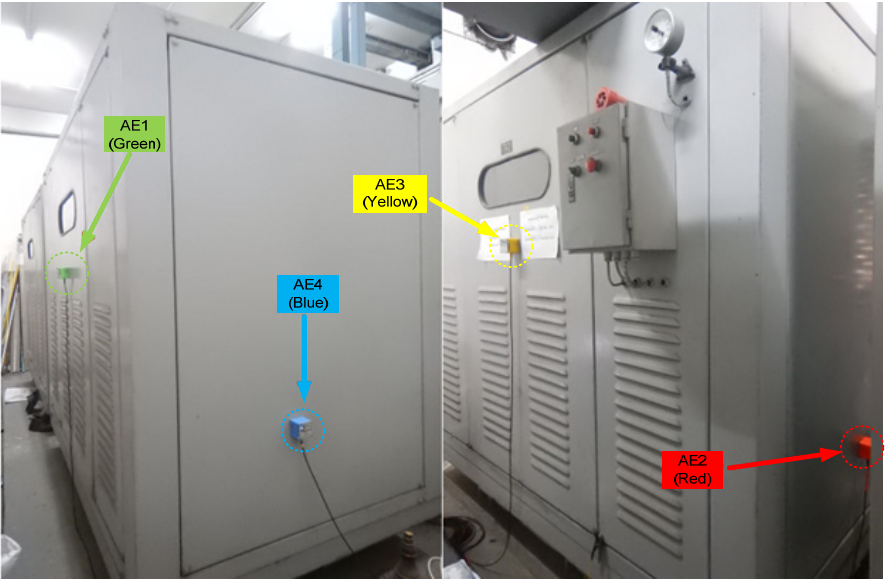
Figure 4. installation of Acoustic Emission Sensor (AE1–AE4) with housing of transformer. Figure 4. Installation of Acoustic Emission Sensor (AE1–AE4) with housing of